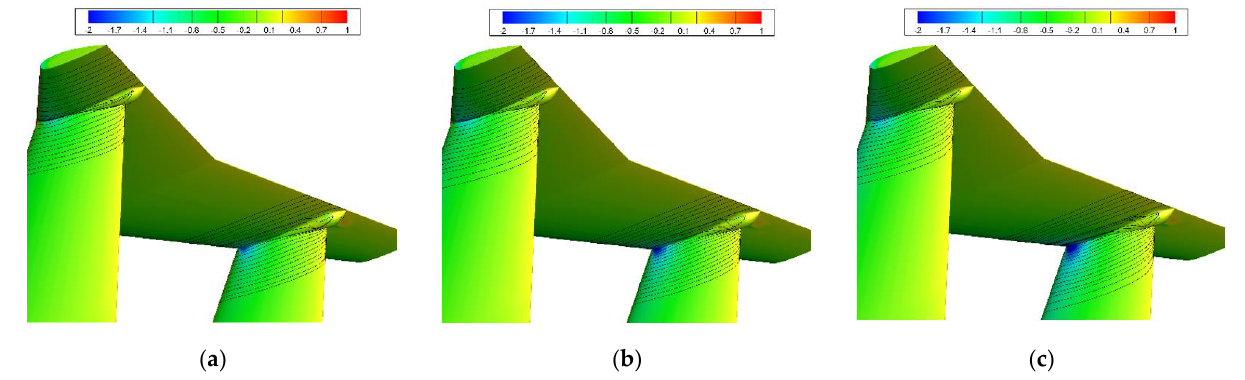
Figure 18. Streamlines and C p distribution on the suction side for the modified model: β = ( a ) 0°, ( b ) 2°, and ( c ) 4°.